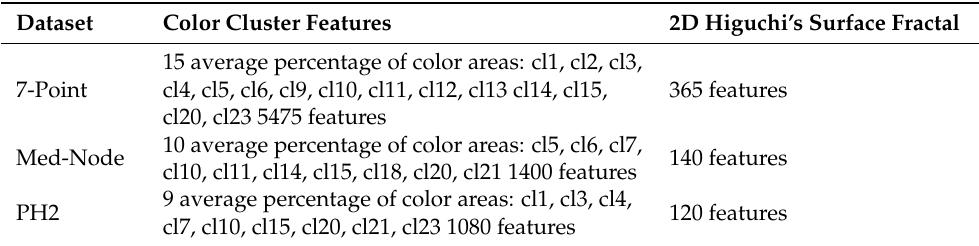
Table 1. Selected features and their numbers used in the experimental analysis.